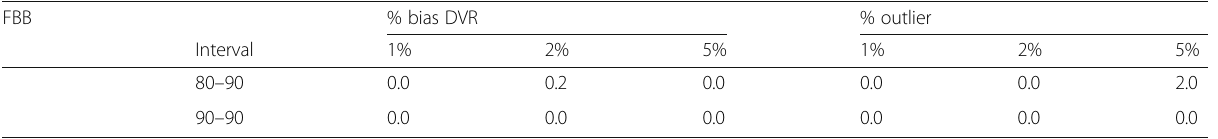
Table 4 Bias in DVR and outliers as a result of noise and the dual-time-window protocol for SRTM-generated [ 18 F]florbetaben TACs (Continued) FBB % bias DVR % outlier